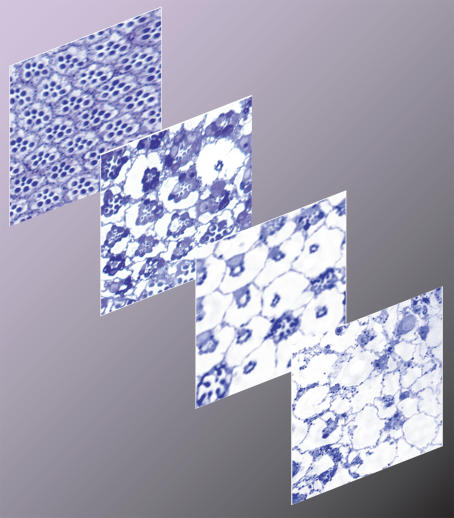

Drosophila photoreceptors that lack NMNAT degenerate very rapidly, as seen in this retina cross section that shows progressive degeneration from wild-type (in the back) to 28-day-old retina (in the front).